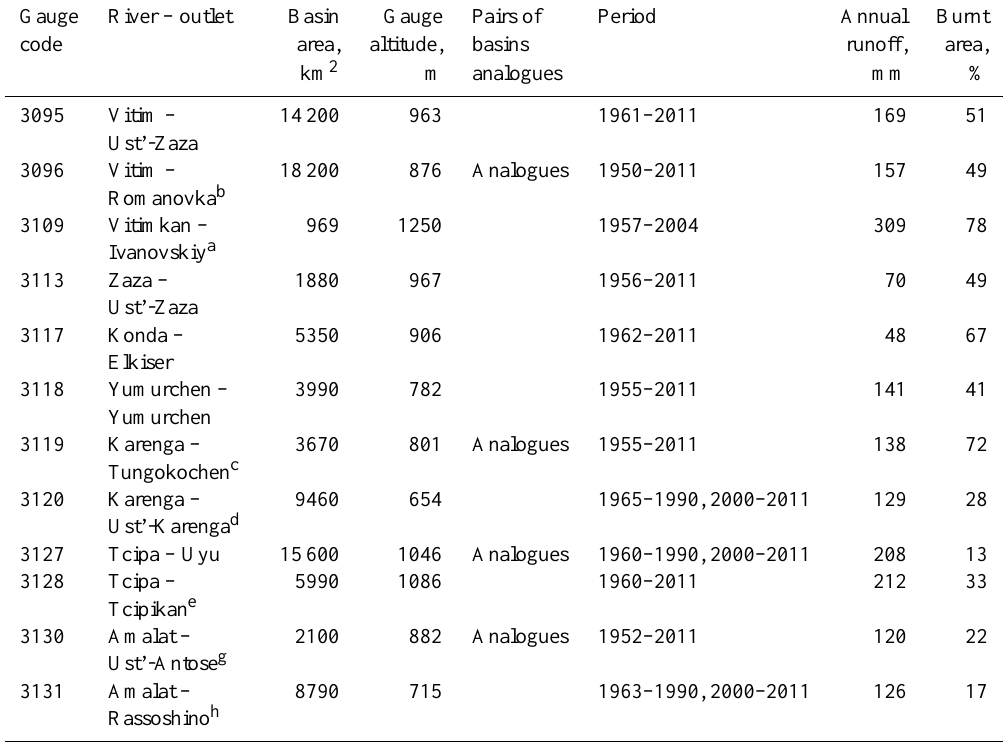
Table 1. The characteristics of the basins under study. Gauge River – outlet Basin Gauge Pairs of Period Burnt code area, altitude, basins runoff, area, km 2 m